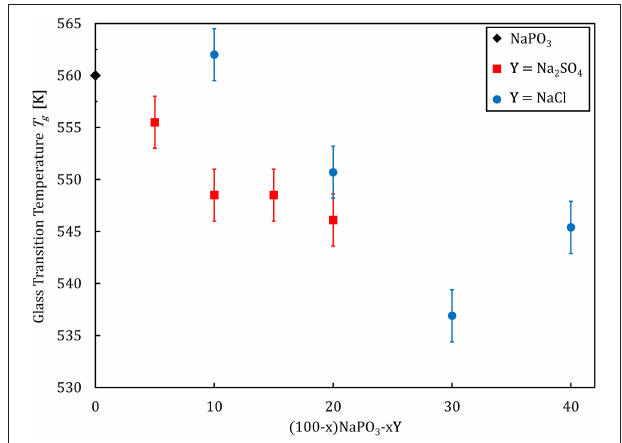
FIGURE 3 | Glass transition temperature as a function of composition for (100–x)NaPO 3 -x Y (with Y = Na 2 SO 4 , NaCl)